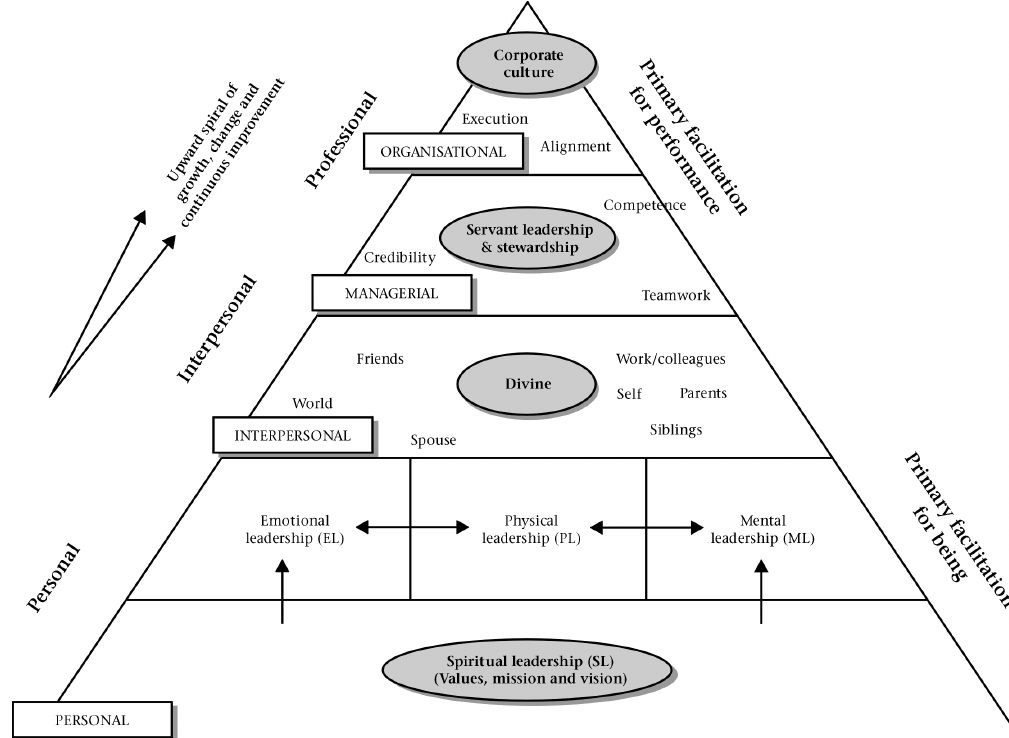
Figure 2: The PiPL Executive Facilitation